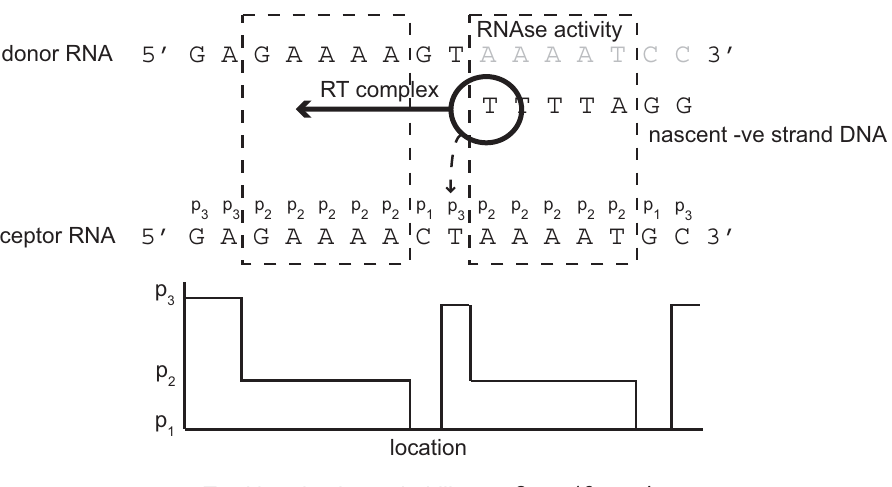
Figure 1. Model of HIV copy-choice recombination. The reverse transcriptase (RT) complex is shown moving from the 3 9 end of the donor RNA to the 5 9 end. The RNAse activity of RT is indicated by the light grey nucleotides on the donor RNA. The nascent negative DNA strand can be observed to the right of the RT complex. A potential strand-transfer event by RT is indicated by the dashed arrow. The dashed boxes indicate windows of decreased probability of crossover that have been anchored to the 5 9 side of each mismatch. The probability of a crossover occurring at each base on the acceptor strand is indicated by p 1 , p 2 , or p 3 as described in Methods. The plot along the bottom is a representation of each of the probability values across the sequence. For this stretch of 16 nucleotides, the total probability of a crossover occurring is given by the equation shown.